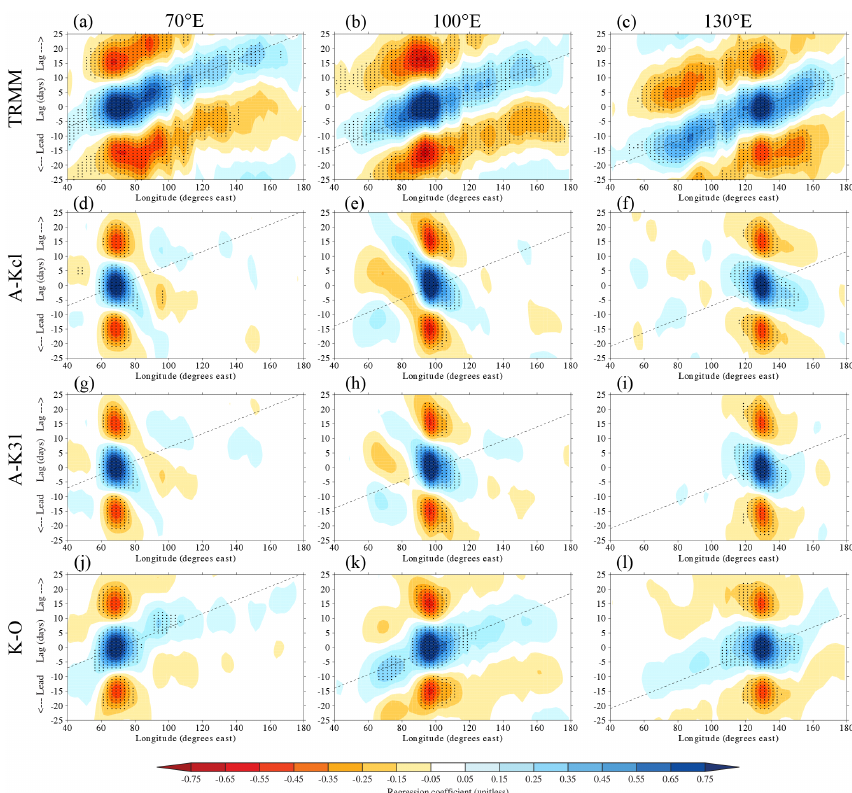
Figure 8. Lag regressions of latitude-averaged (15 ◦ N–15 ◦ S), 20–80-day bandpass-filtered precipitation against base points in the central Indian Ocean (70 ◦ E; a, d, g, j ), maritime continent (100 ◦ E; b, e, h, k ) and western Pacific (130 ◦ E; c, f, i, l ). Positive and negative days represent lags and leads, respectively. Approximate observed propagation speeds are shown by the dashed lines. Stippling indicates where the lag regressions are significant at the 95%